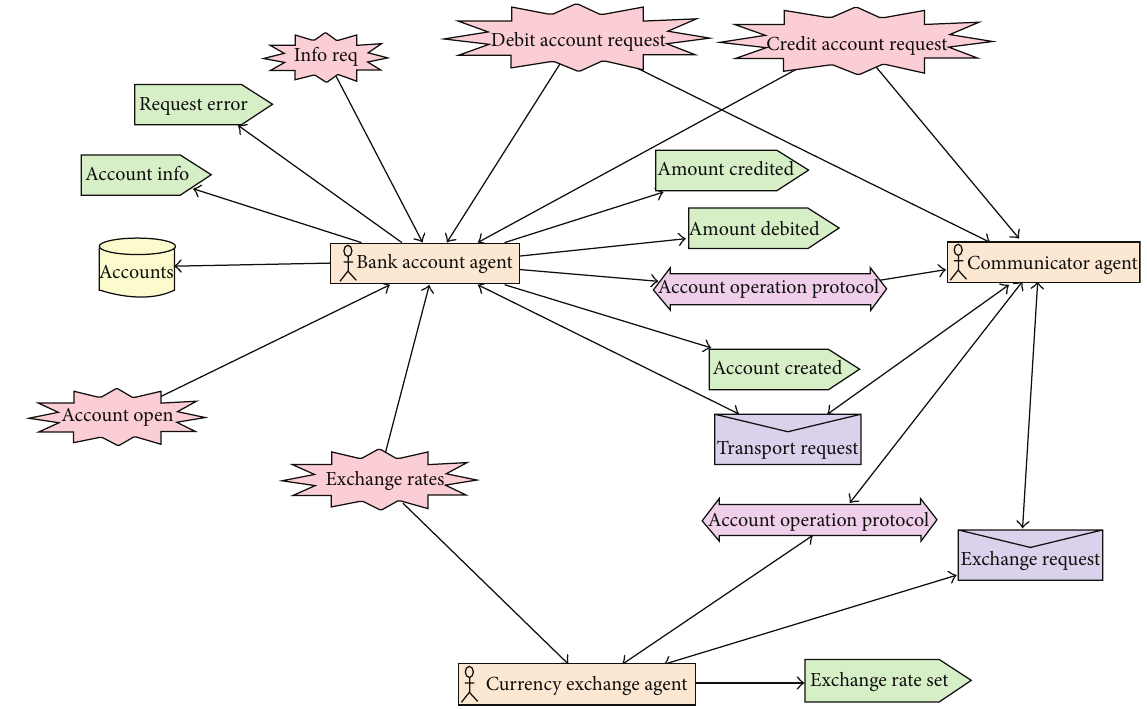
Figure 5: System overview diagram of multiagent system.